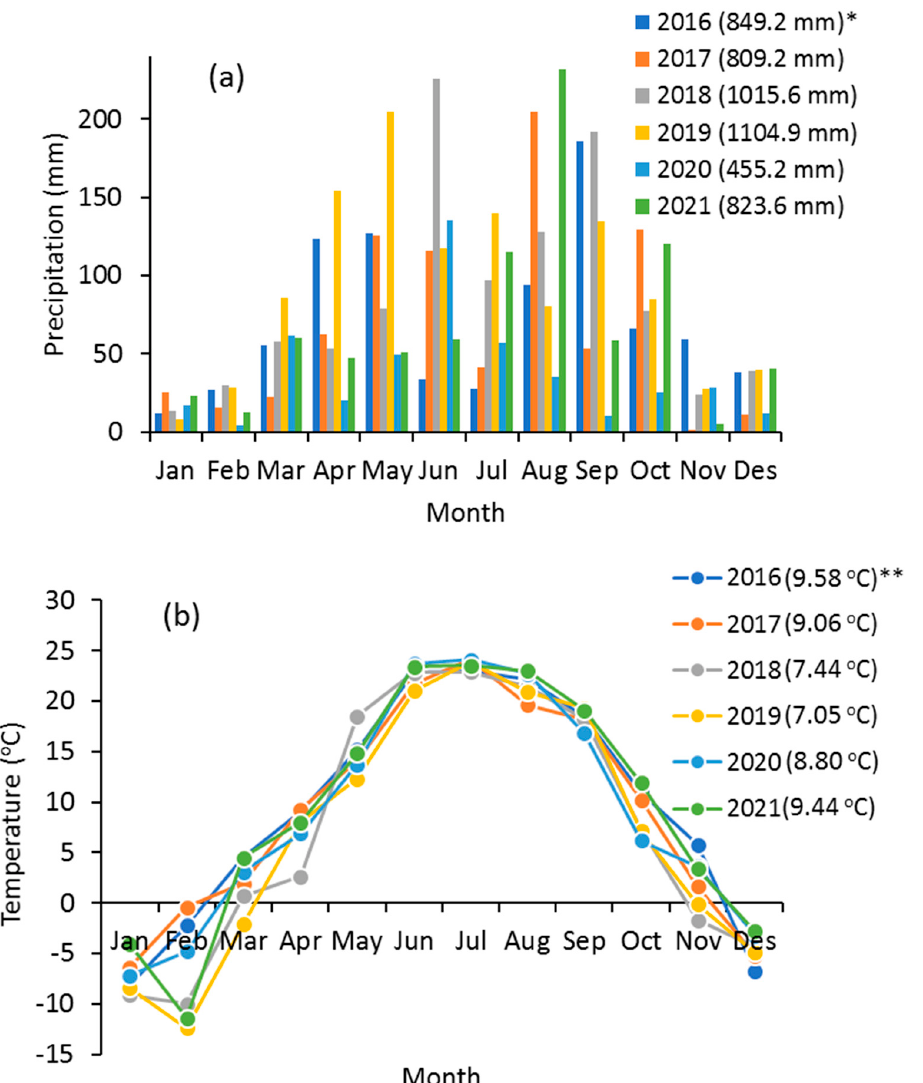
Figure 2. Average monthly precipitation and temperature from 2016 to 2021 (* cumulative precipitation; ** annual average temperature).